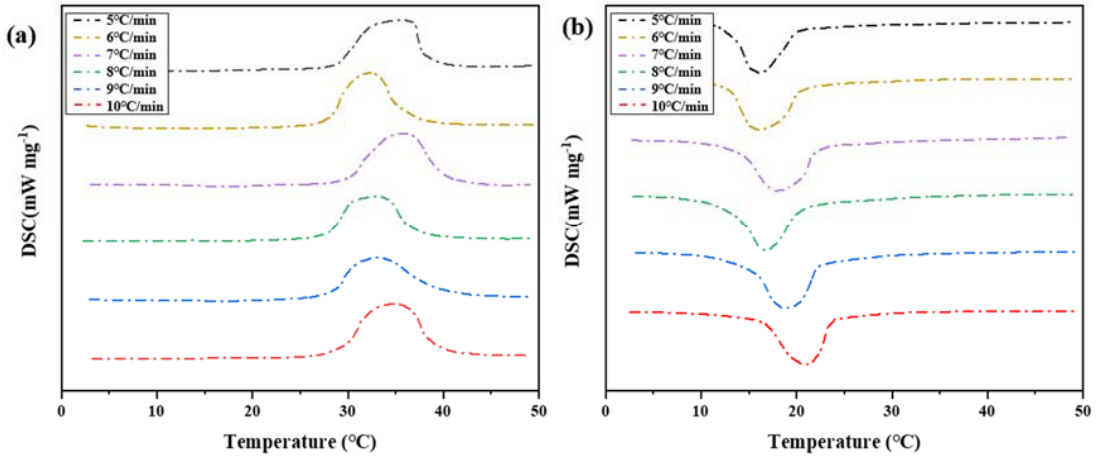
Figure 16. DSC characterization of phase transition properties of binary composite phase change materials at different cooling rates. ( a ) DSC curve of the second temperature rise. ( b ) DSC curve of the first cooling. Table 6. Thermal performance parameters measured by DSC at different cooling rates.